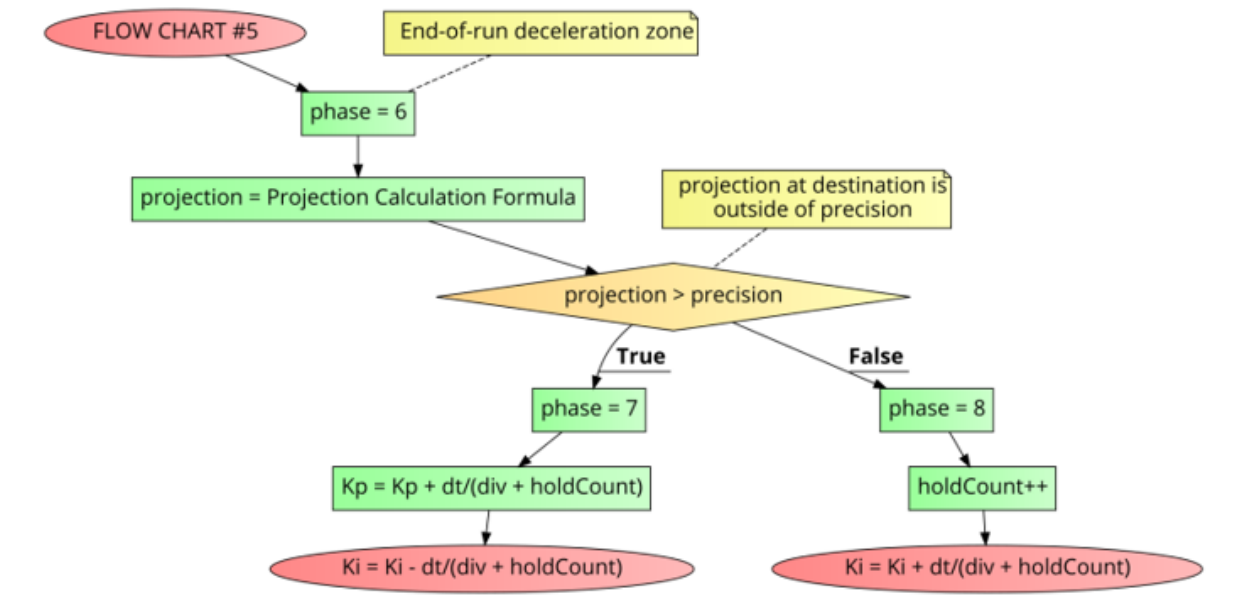
Figure 12. PID++ Flow Chart #5—second half of run (end of run deceleration zone). (( Vcurrent − Vlast projection = abs